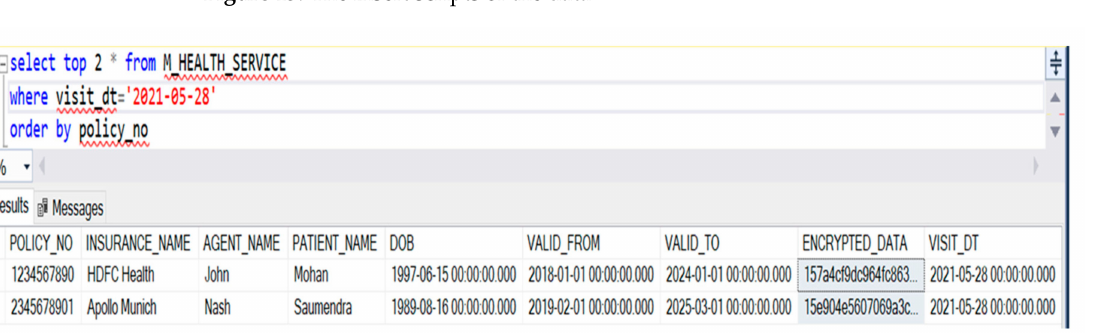
Figure 14. An instance referred to where the admin wants to access the top 2 patient insurance